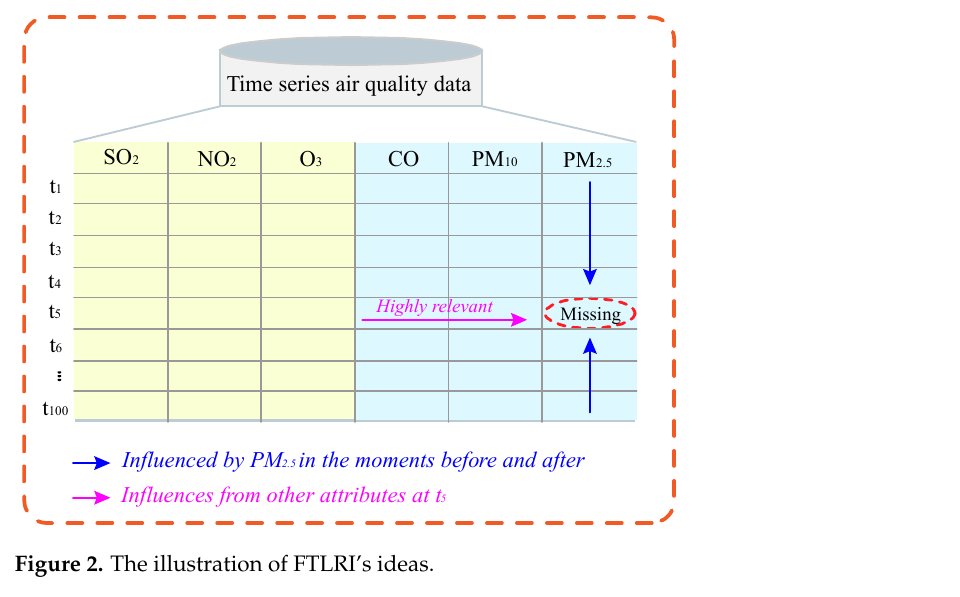
Algorithm 1 First five last three logistic regression imputation (FTLRI)